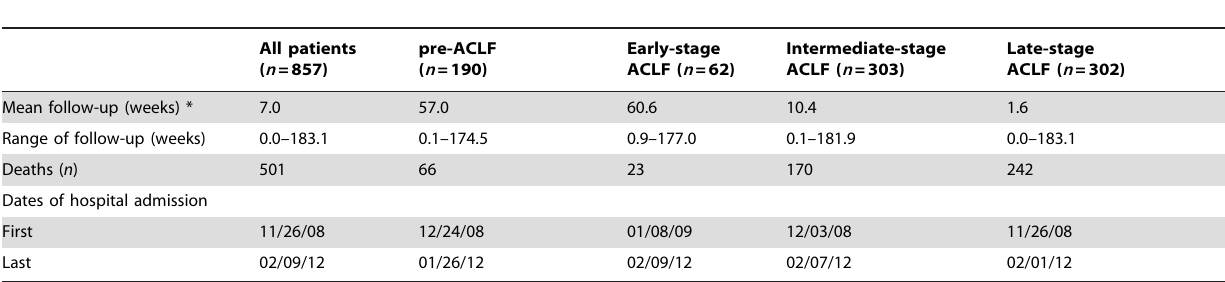
Table 2. Follow-up data for the patients who did not undergo liver